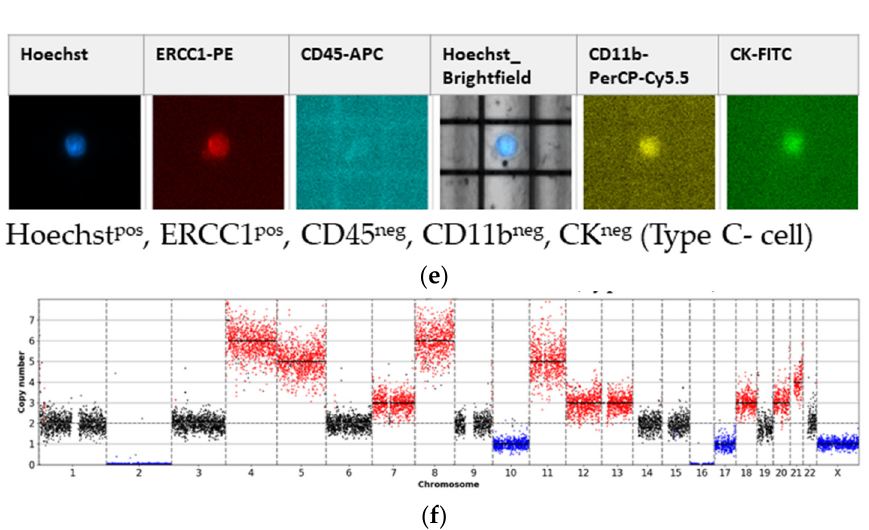
Figure 2 . DEPArray TM fluorescence panel from different single cell types and matched CN profiles. Ploidy levels were automatically approximated based on the underlying copy number levels, amplifications (red) and deletions (blue) are based on the estimated ploidy. ( a ) Type A-cell, Hoechst pos , ERCC1 pos , CD45 neg , CD11b pos , CK pos ; patient 10. ( b ) Matched CN profile of Type A-cell ( a ) with a ploidy of 6. ( c ) Type B-cell, Hoechst pos , ERCC1 pos , CD45 neg , CD11b pos , CK neg ; patient 11. ( d ) Matched CN profile of Type B-cell ( c ) with a ploidy of 5. ( e ) Type C-cell, Hoechst pos , ERCC1 pos , CD45 neg , CD11b neg , CK neg ; patient 12. ( f ) Matched CN profile of Type C-cell ( e ) with a ploidy of 2.